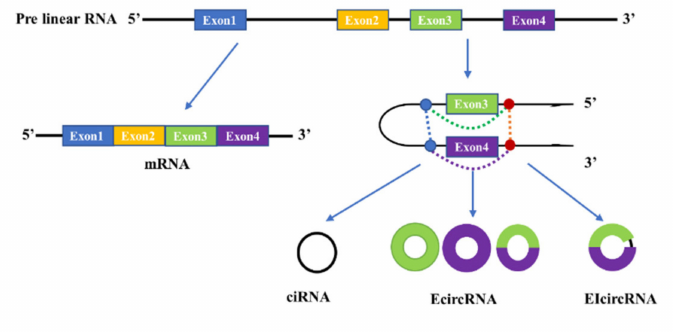
Figure 1. The proposed models of circRNAs biosynthesis. The mature mRNA containing all exons and the three types of circRNAs produced by back-splicing possibly occurred in Exon3 and Exon4. Intronic circular RNA (ciRNA) only includes the sequence of Intron3, and the exonic circular RNA (EcircRNA) may include the sequence of Exon3, Exon4 or mixed sequnece of Exon3 and Exon4. The exon–intron circular RNA (EIcircRNA) includes the sequence of Exon3, Exon4 and